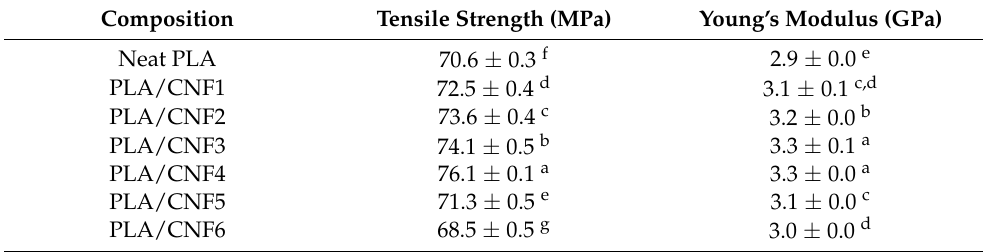
Table 3. Mechanical properties of neat PLA and PLA/CNF nanocomposites.